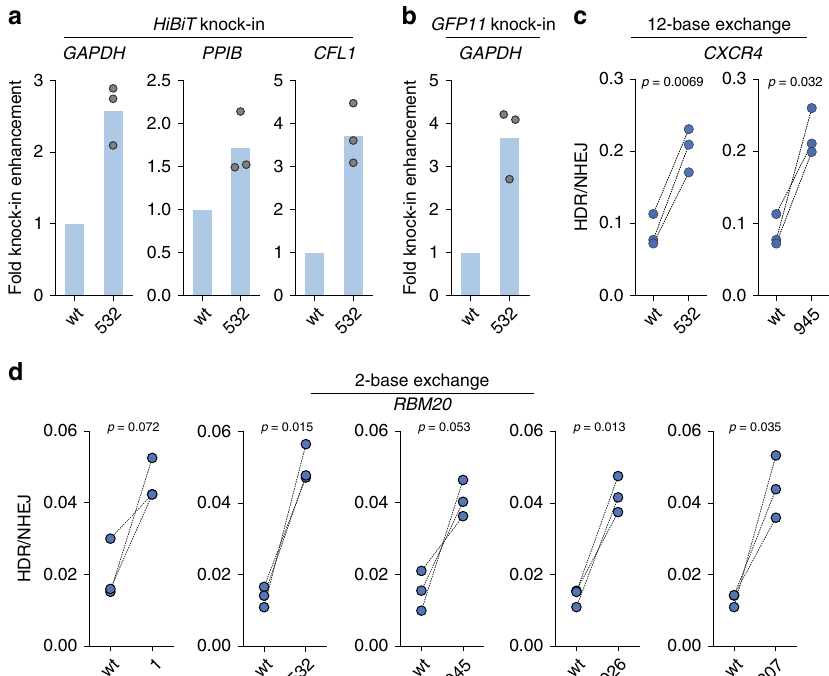
Fig. 3 ssODN display platform allows facile testing of multiple conditions. a HiBiT sequence knockin ef fi ciency was increased at multiple genomic loci in U2OS cells ( GAPDH and PPIB ) or HEK-293FT cells ( CFL1 ), ( n = 3 biologically independent experiments). b The GFP11 sequence insertion at the GAPDH locus was promoted in HEK-293T cells ( n = 3 biologically independent experiments). c HDR-mediated 12-base exchange ef fi ciency at the CXCR4 locus was increased in HEK-293T cells ( n = 3 biologically independent experiments). d Two-base exchange at the RBM20 locus was promoted in HEK-293FT cells. Unlabeled wild-type Cas9 (wt) and Cas9-adaptor conjugates labeled at the indicated residues were used ( n = 3 biologically independent experiments). P -values were calculated by paired two-tailed t -test. Source data are provided as a Source Data fi site (1). An examination of the crystal structure 22 indicates that